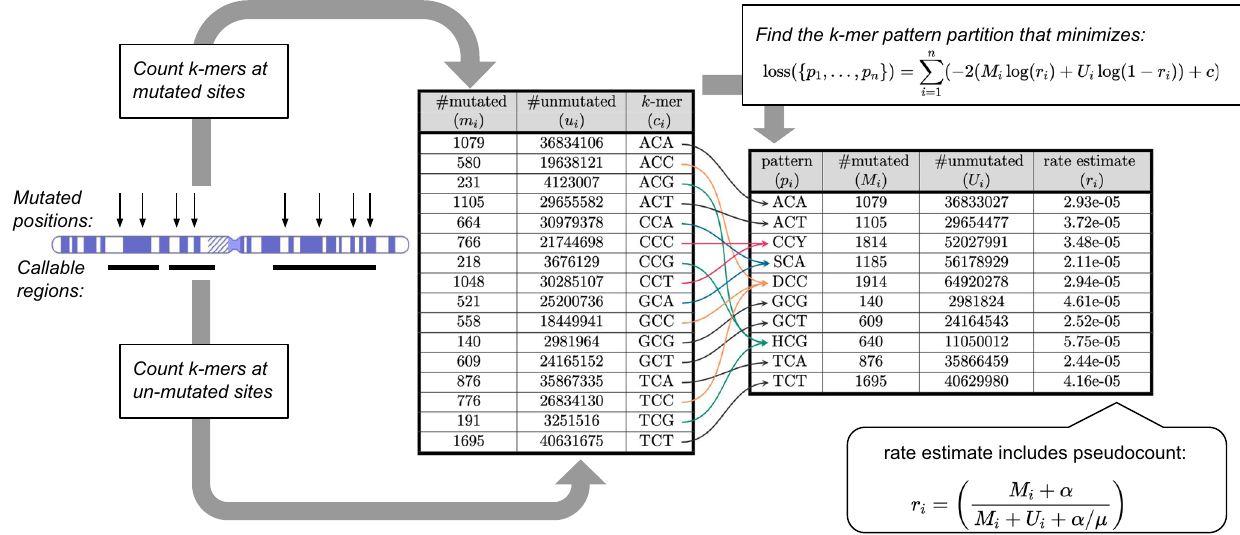
Fig. 1 | Overview of k-mer pattern partitioning (kmerPaPa) model. Input data consists of a list of observed mutations (here C → G mutations) and a bed fi le with regions suf fi ciently covered by WGS data to detect mutations. From this, we cal- culate a table with the number of times each possible k-mer is observed with the